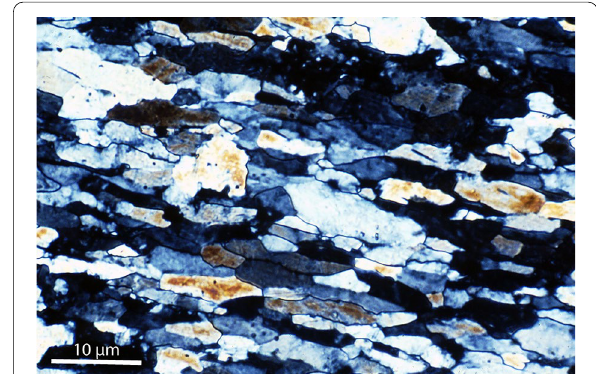
Fig. 20 Thin-section of Quinten limestone showing shape preferred orientation of calcite grains